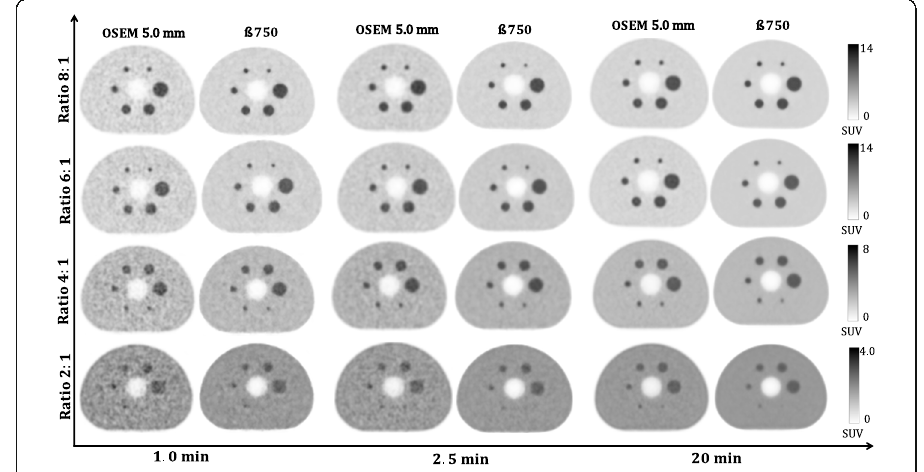
Fig. 5 Qualitative evaluation of the transaxial images of the NEMA phantom of TOF-OSEM (3 iterations, 16 subsets, post-filter 5.0 mm and PSF) and BSREM with β = 750 (including TOF and PSF). Contrast ratios of 8:1, 6:1, 4:1, and 2:1 are shown in rows and acquisition times (1.0, 2.5, and 20 min) in column. Background